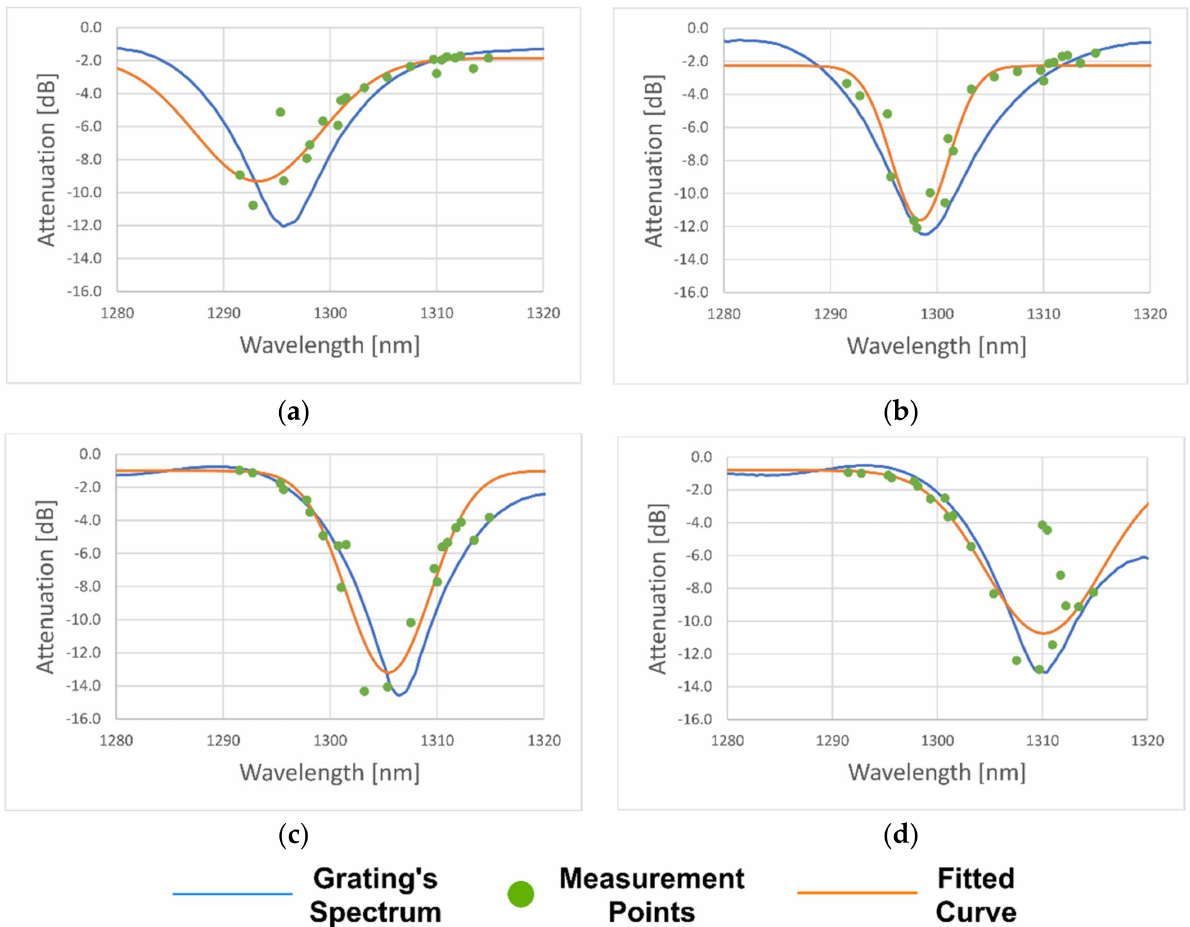
Figure 10. Interrogations done along the measurable spectrum, the blue line represents the grating spectrum measured with an optical spectrum analyzer, green dots are the measurement points, and the orange line represents the fitted Gaussian curve. ( a ) long period fiber gratings (LPFG) centered at 1295.6 nm; ( b ) LPFG centered at 1298.8 nm; ( c ) LPFG centered at 1306.4 nm; ( d ) LPFG centered at 1310.0 nm.